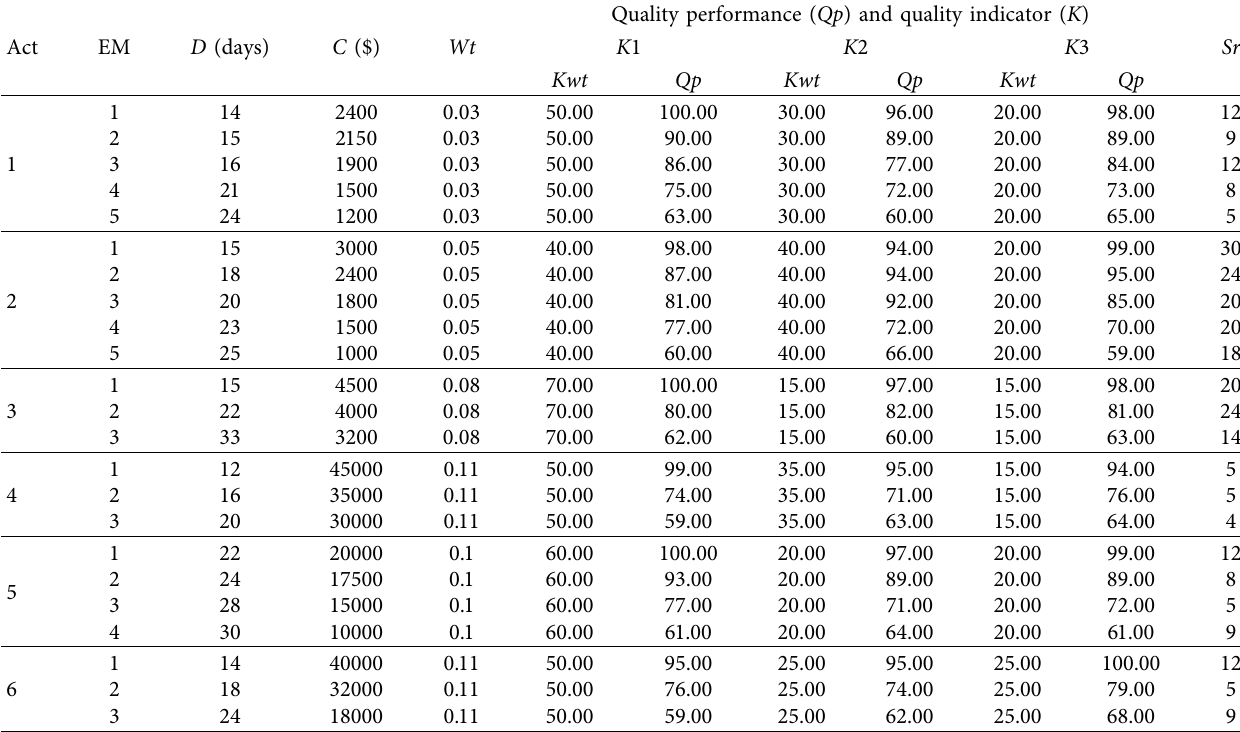
Table 4: Data resources for case